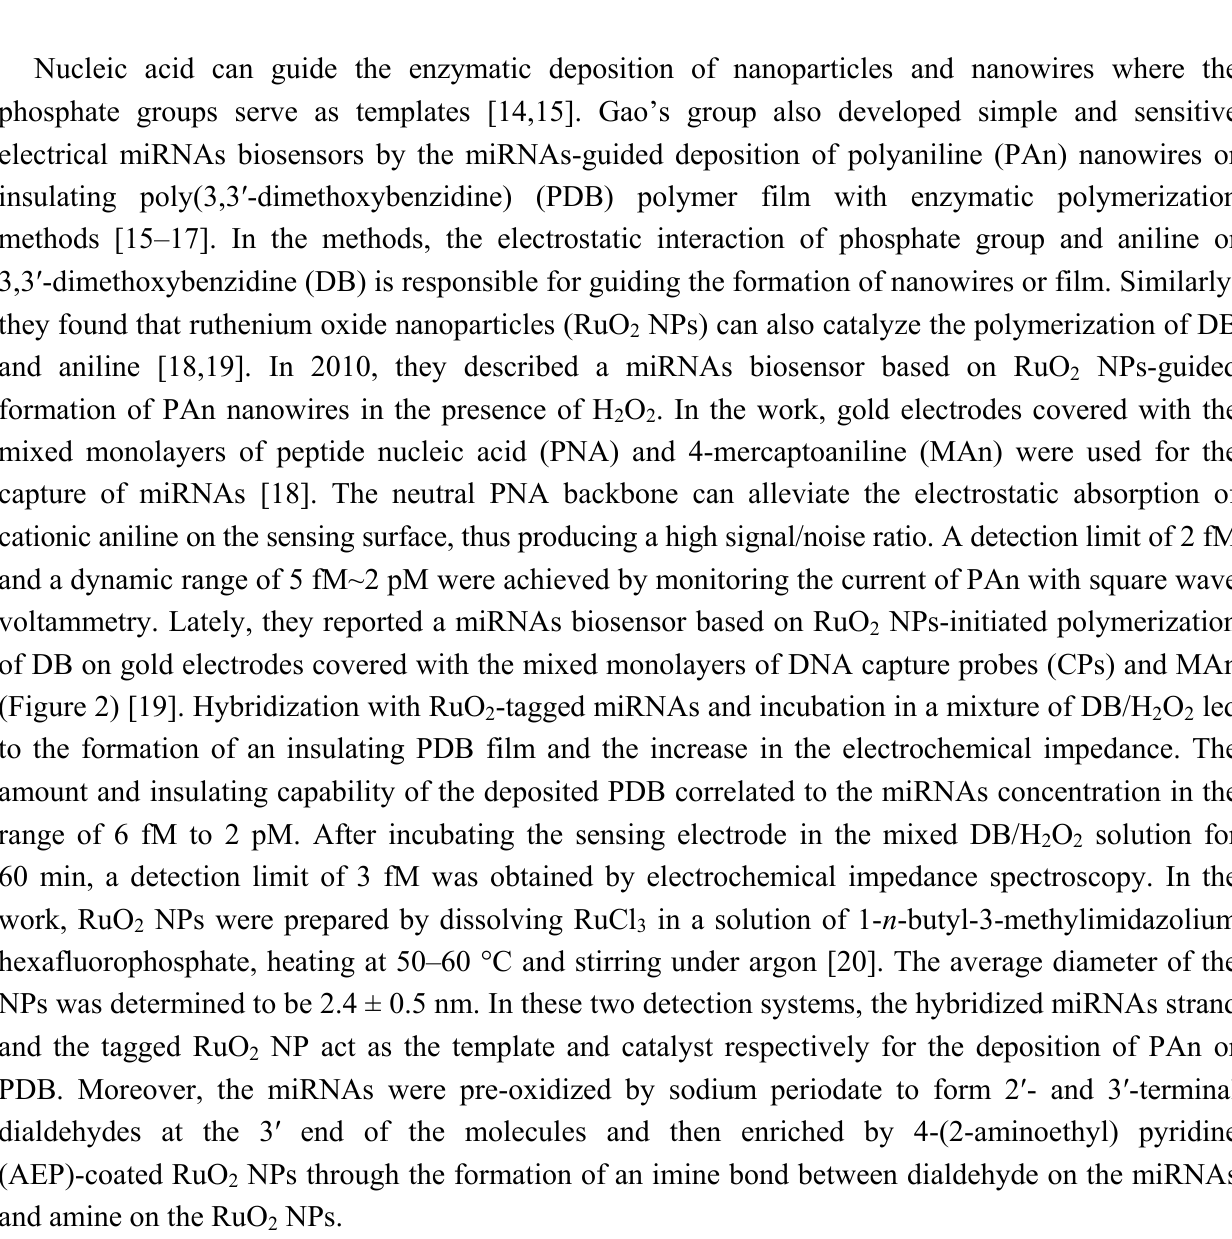
NPs-catalyzed 2